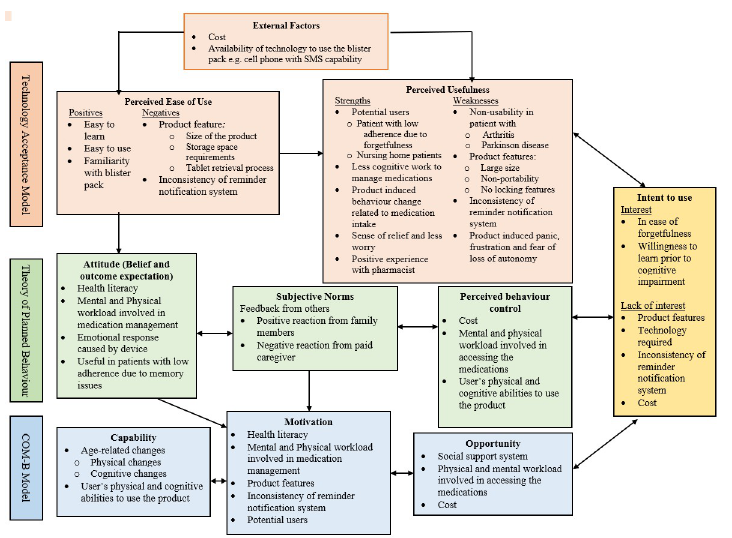
Fig 4. Factors impacting integration of smart